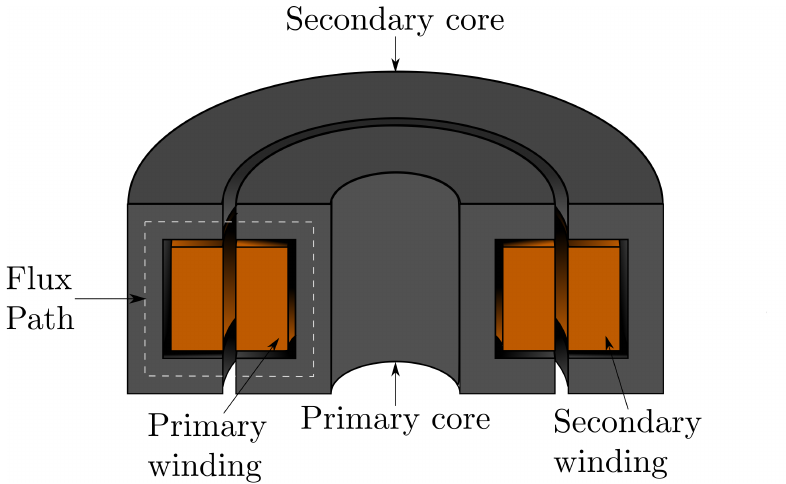
Figure 1. Coaxial topology for rotary transformers.